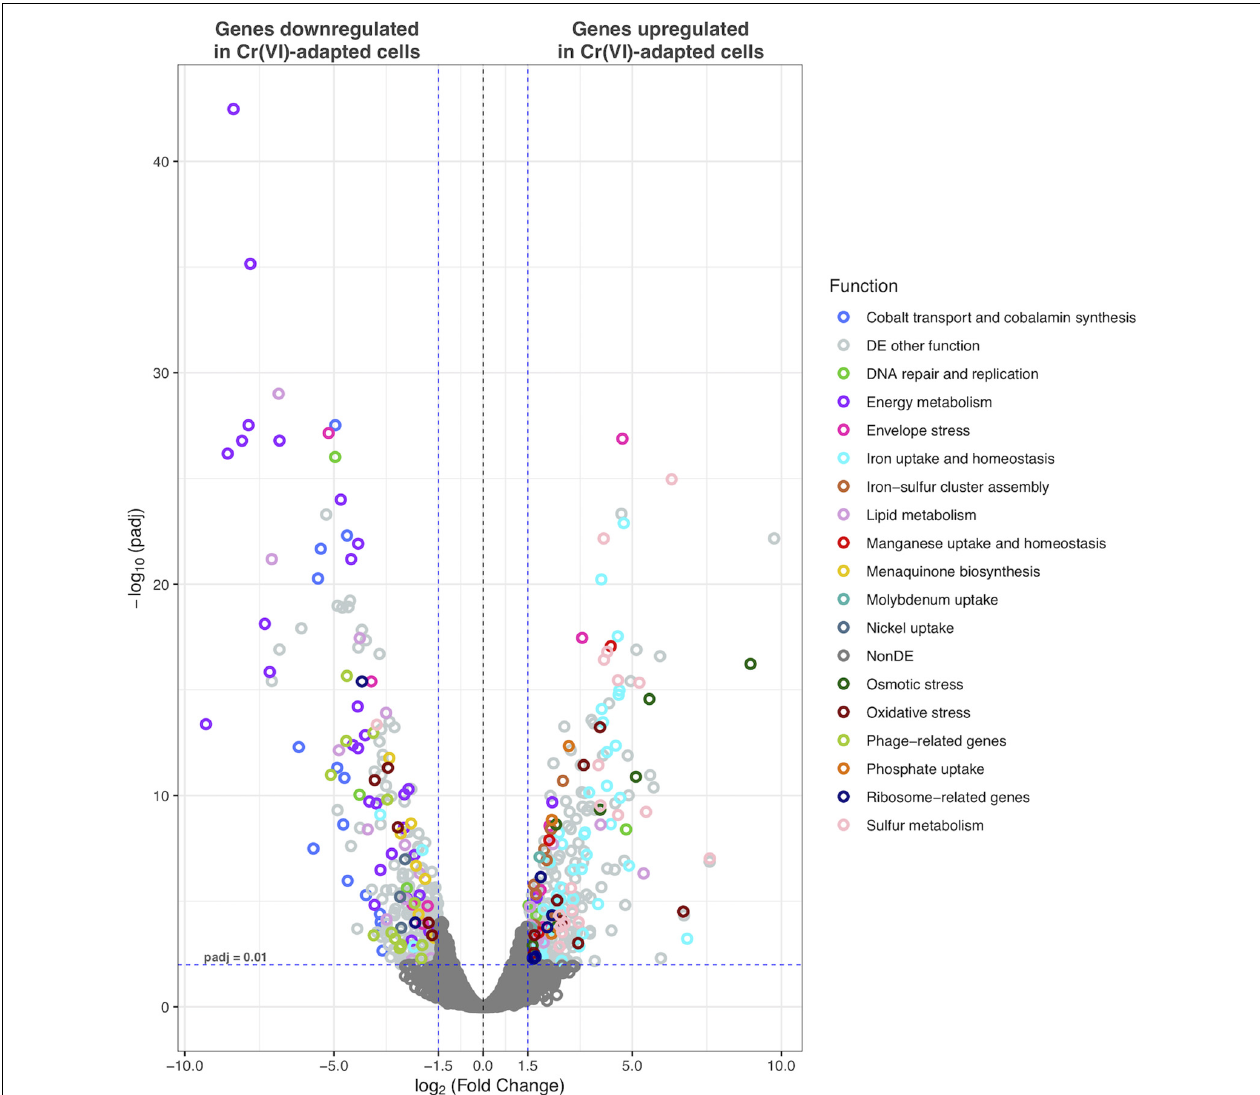
FIGURE 6 | Volcano plot displaying differentially transcribed genes between Cr(VI)-adapted cells and controls. Each dot represents an ORF. ORFs with p -adj ≤ 0.01 and |Log2FC| > 1.5 were considered as differentially transcribed. Genes with putative functions previously associated with Cr(VI)-response in other bacteria are